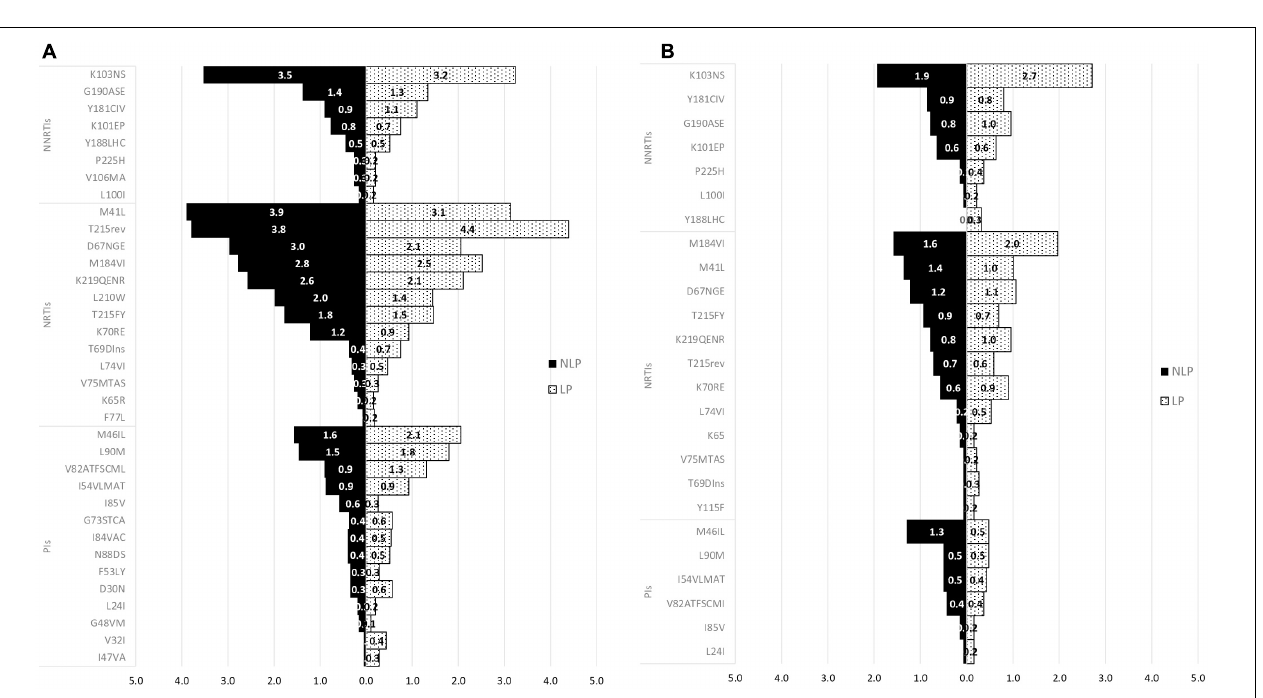
FIGURE 6 | Mutations in Non-Late presenters (NLP) and Late presenters (LP) in subtype B (A) and subtype non-B (B) for ART-naïve patients. PIs, protease inhibitors; NRTIs, nucleoside reverse transcriptase inhibitor; NNRTIs, non-nucleoside reverse transcriptase inhibitor.